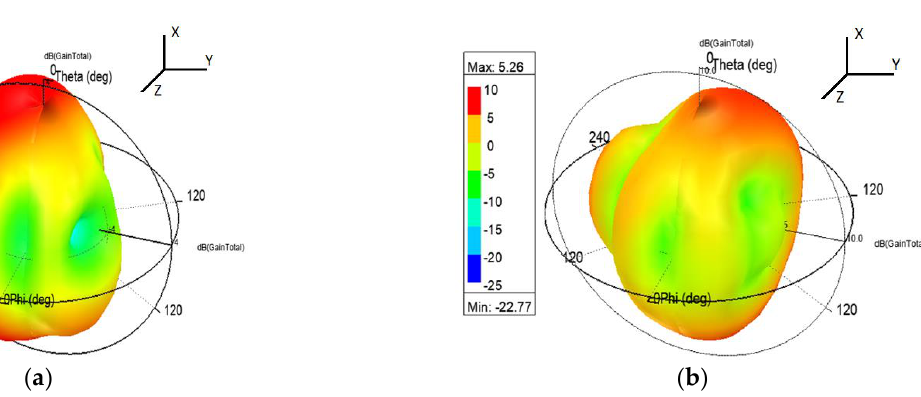
Figure 12. 3-Dimension radiation pattern. ( a ) 3.63 GHz frequency ( b ) 4.94 GHz frequency